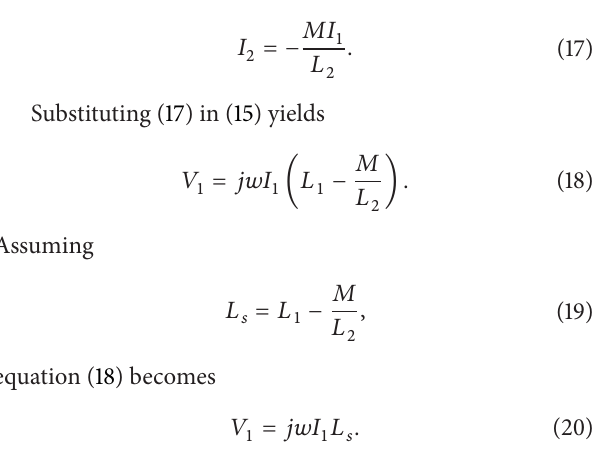
Table 1: Dimensions of simulated coils (in mm).